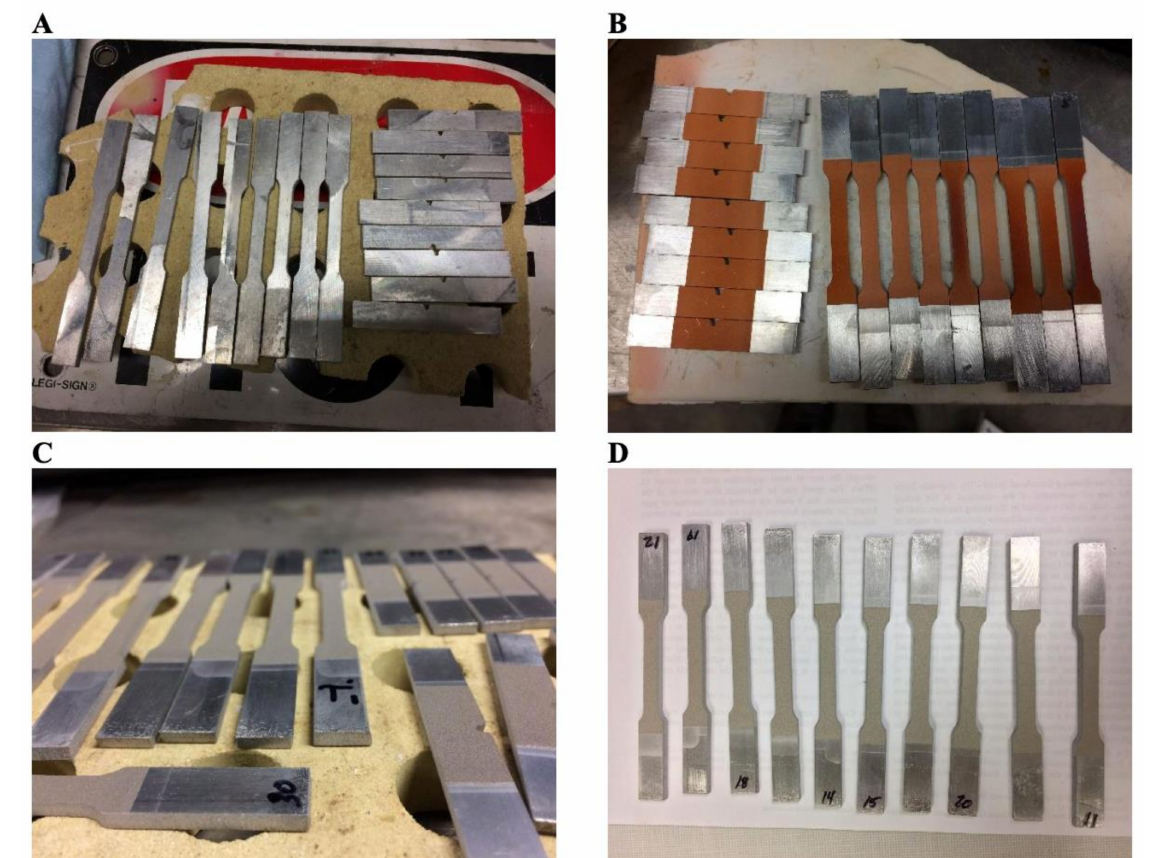
Figure 1. ( A ) Digital image of the waterjet cut HPDC A365 substrate/base material as reference specimens that therefore did not undergo cold gas dynamic spray (CGDS) processing. ( B ) Digital photo of the thinly coated and Cu CGDS processed A365 HPDC substrate specimens. ( C , D ) Digital images are similar to ( B ), where Ni and Ti were utilized as feedstock, respectively. For reference, the thickness of the base material (see ( C ) with the properly oriented specimen labeled “30”) was 2.5 mm before CGDS processing or postprocessing after